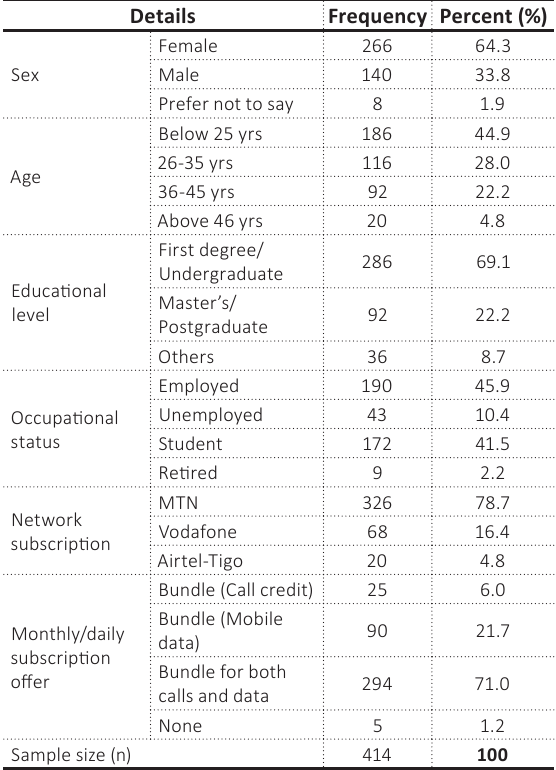
Table 1. Socio-demographic profile of study